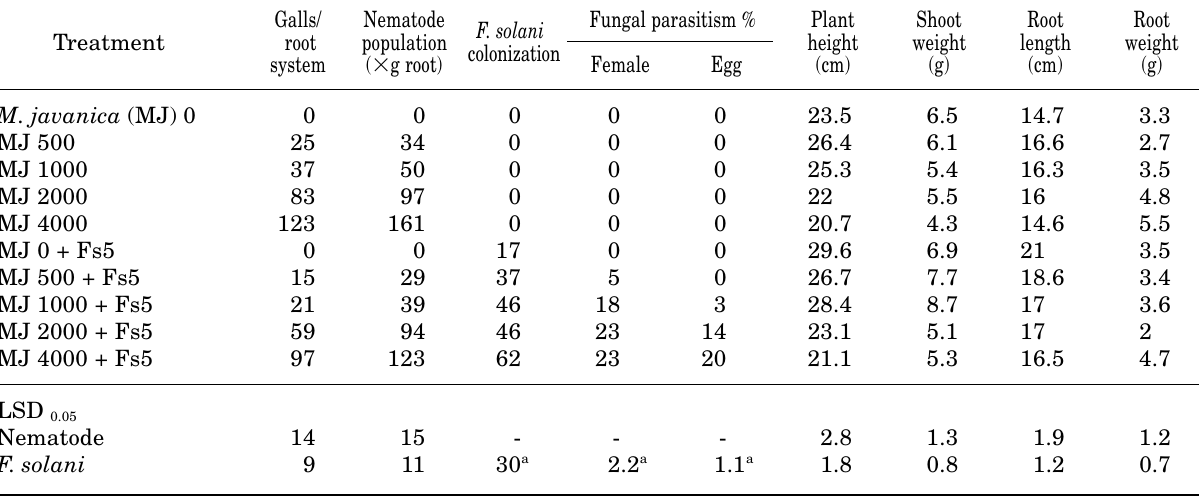
Table 1. Effect of Fusarium solani strain Fs5 on various population densities of Meloidogyne javanica on tomato, as shown by development of root-knot infection, M. javanica invasion, root colonization by F. solani , female and egg parasitism of M. javanica by the fungus, and growth of tomato plants. Galls/ Nematode Fungal parasitism F. solani